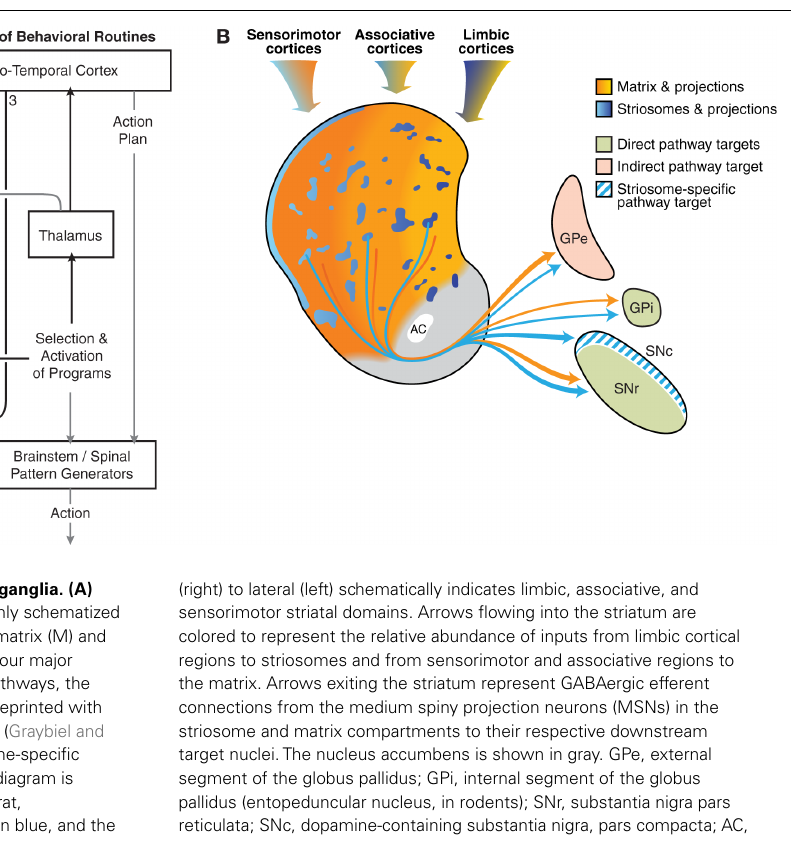
FIGURE 1 | Neuroanatomical connections of the basal ganglia. (A) Schematic diagram of major basal ganglia circuits with highly schematized indications of component functions.The striatum with its matrix (M) and striosomal (S) compartments is centered in the diagram. Four major pathways are emphasized: the direct (1) and indirect (2) pathways, the hyperdirect pathway (3), and the striosomal pathway (4). Reprinted with permission from The Cognitive Neurosciences , 4th Edition (Graybiel and Mink, 2009). (B) Model of the direct, indirect, and striosome-specific striatal projection pathways from the dorsal striatum.The diagram is based on a cross-section through the striatum of an adult rat, immunostained for CalDAG-GEFII. Striosomes are shown in blue, and the extra-striosomal matrix in orange. Shading of the striatum from medial